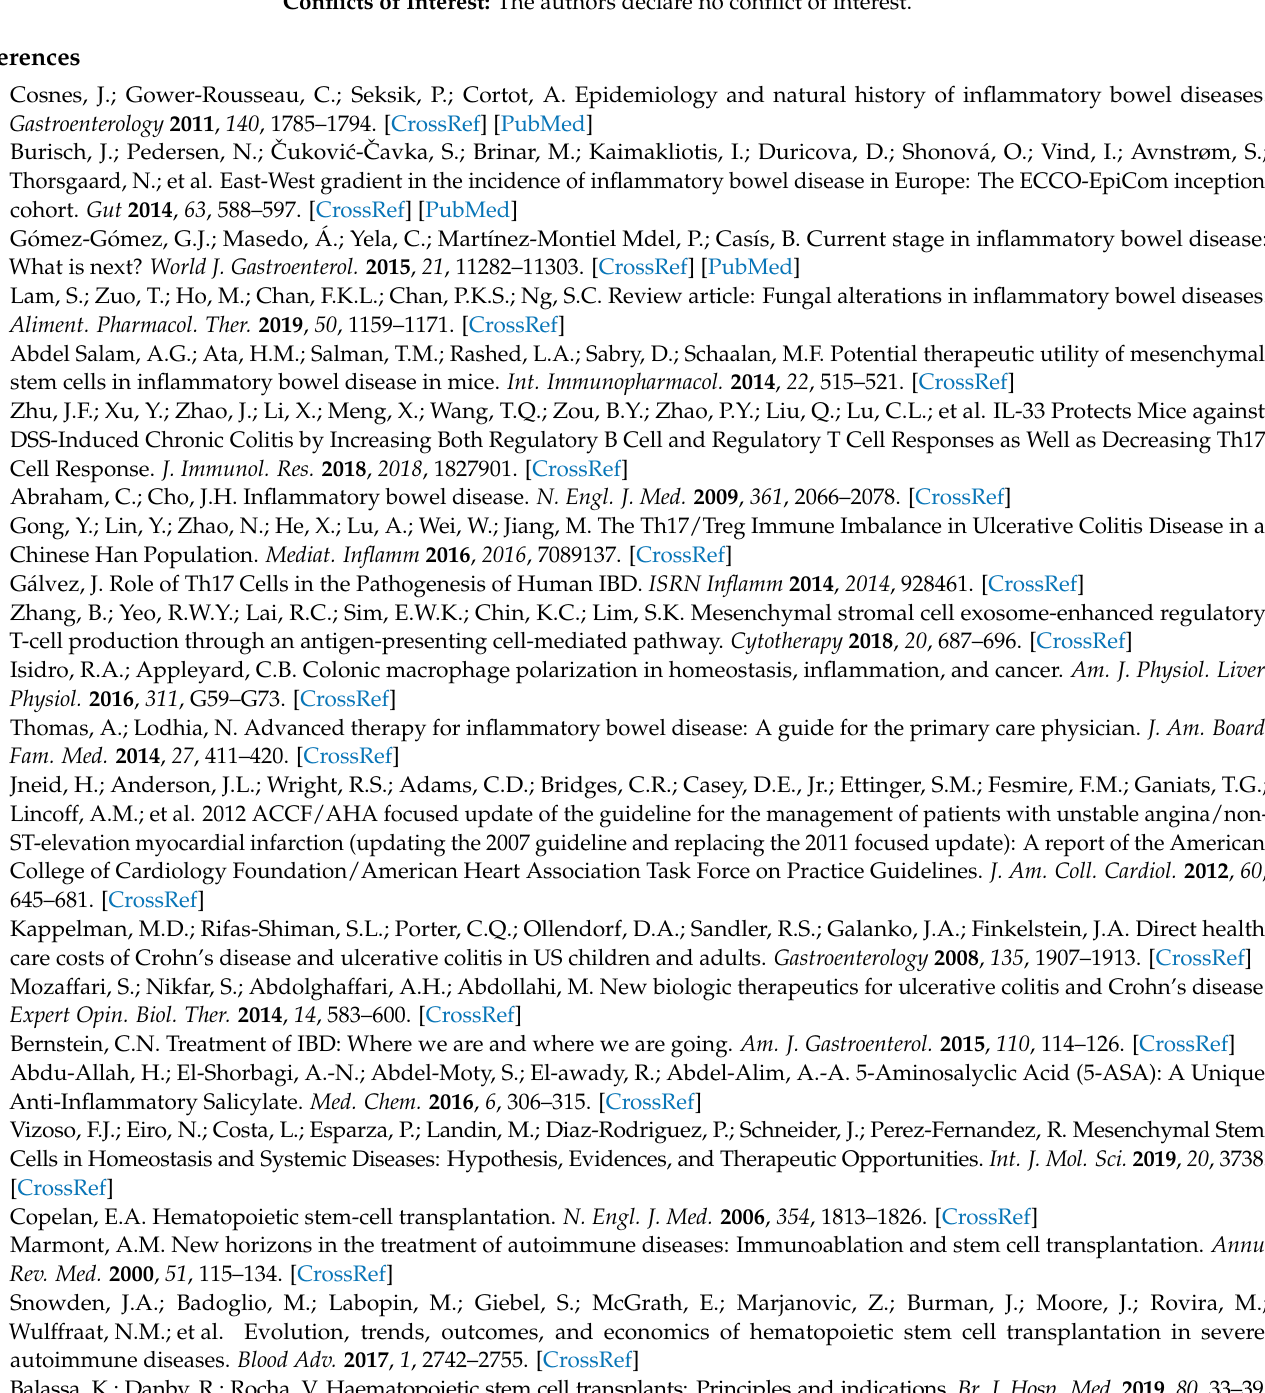
table and figure. F.J.V. and N.E. designed the project and wrote the manuscript. All authors reviewed the manuscript. All authors have read and agreed to the published version of the manuscript. Funding: This research was supported by grants to N.E. and F.J.V from Instituto de Salud Carlos III (PI20/01122) and co-funded by European Union (ERDF/ESF, “Investing in your future”). Conflicts of Interest: The authors declare no conflict of